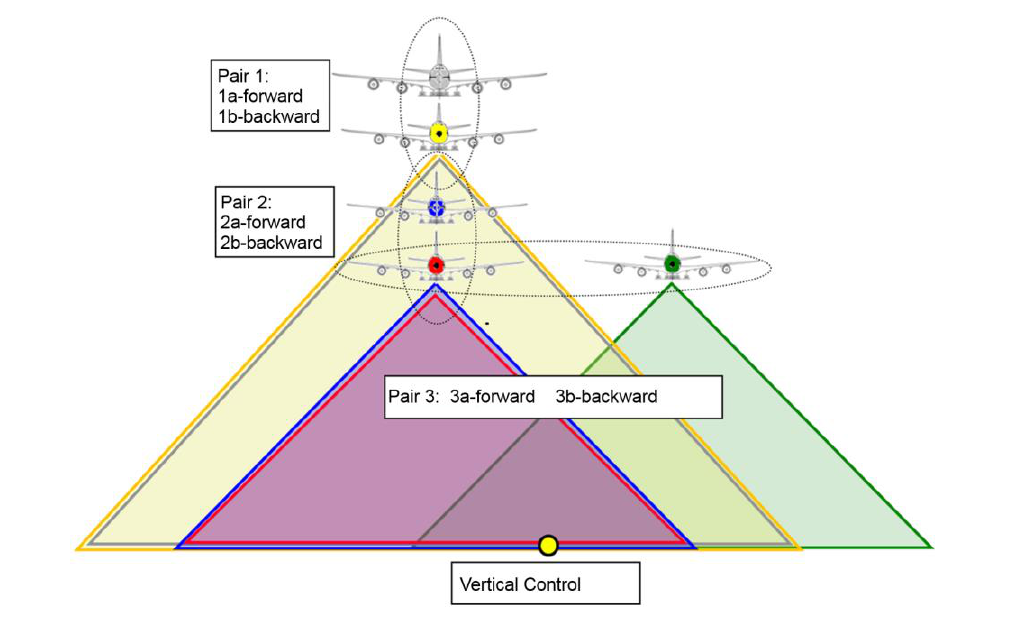
Figure 2: Optimal Flight and Control